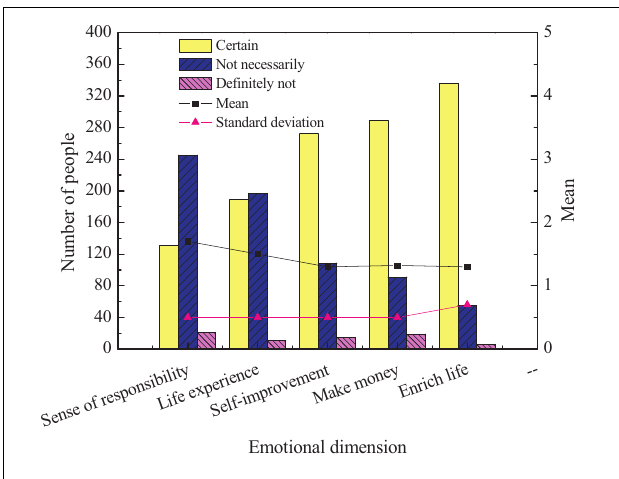
FIGURE 7 | Comparison of students’ entrepreneurial emotion.